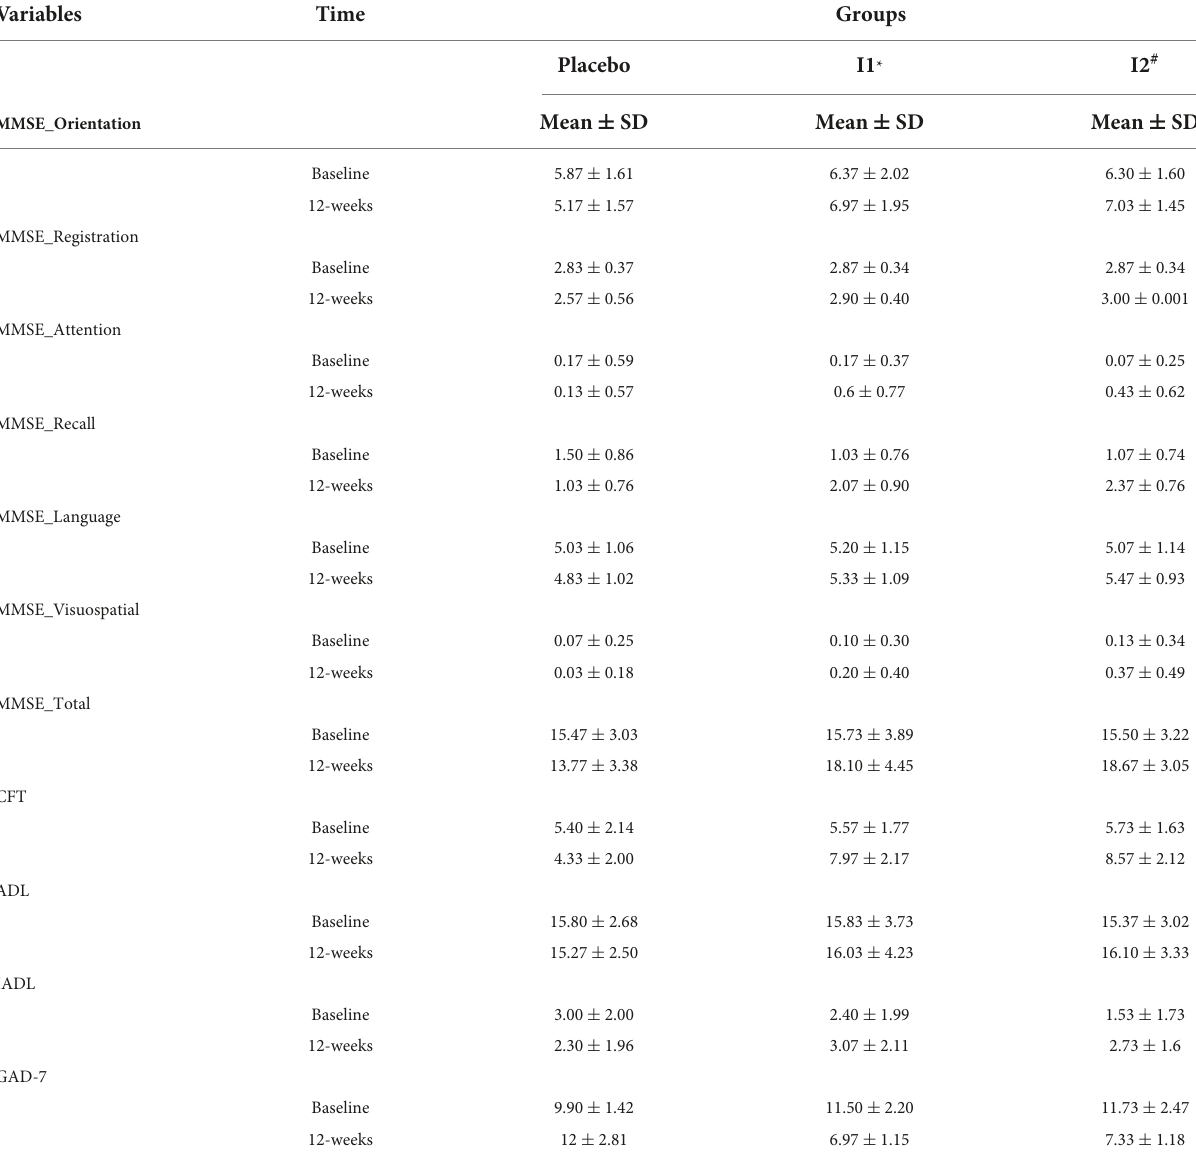
TABLE 2 Mini-Mental State Examination, CFT, ADL, IADL, and GAD scores of patients in the intervention groups and the placebo group over the study period. a